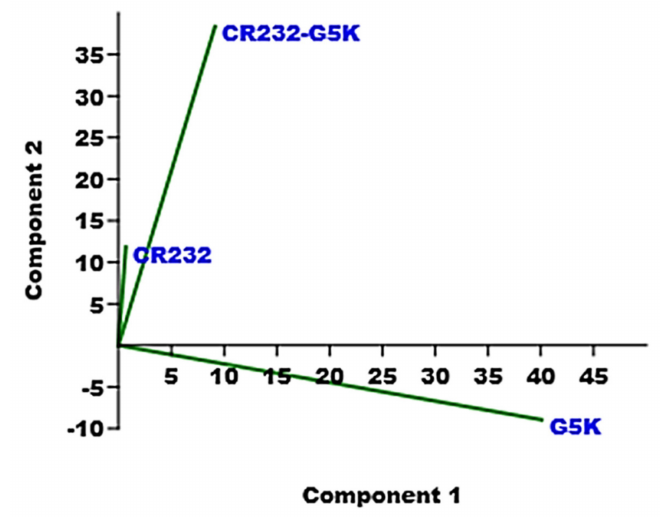
Figure 8. Results of PCA (represented as a score plot) performed on the matrix collecting the spectral data of CR232, G5K, and CR232-G5K (PC1 vs. PC2).